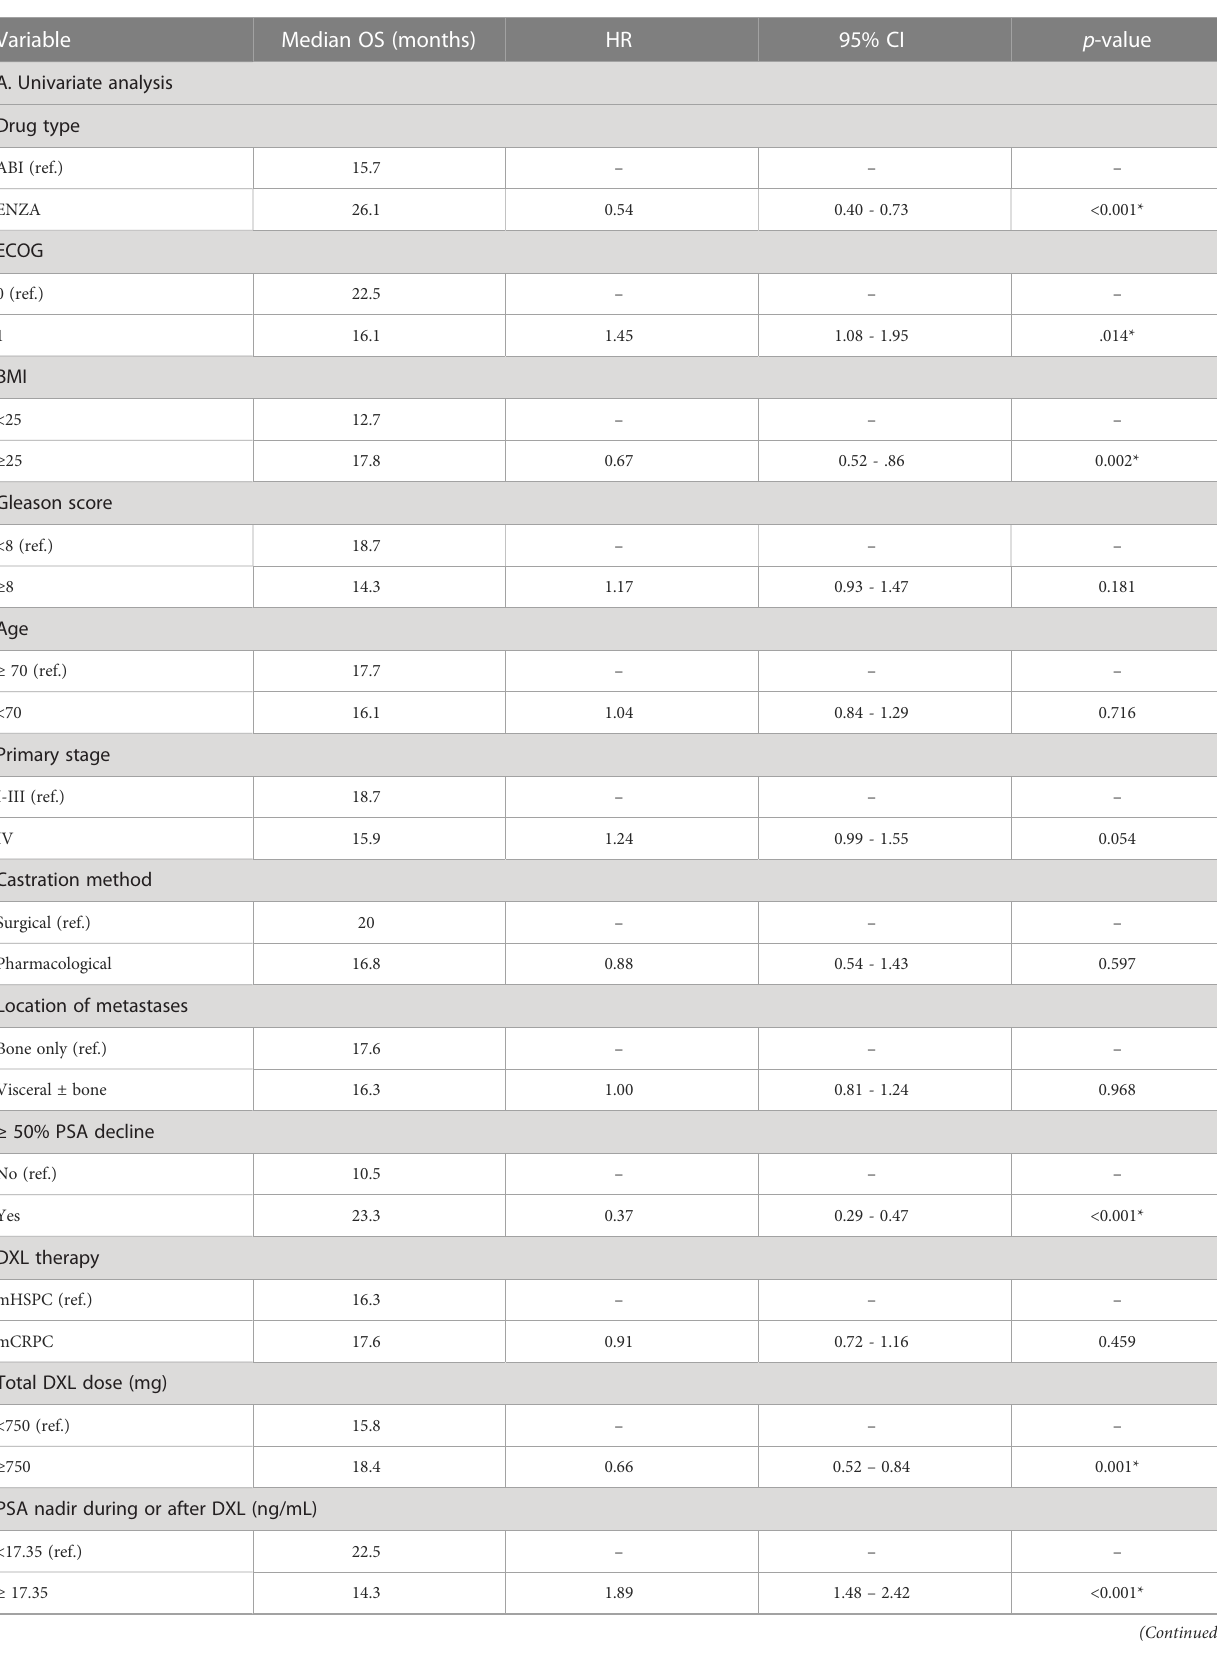
TABLE 3 Prognostic factors determining the overall survival (univariate and multivariate